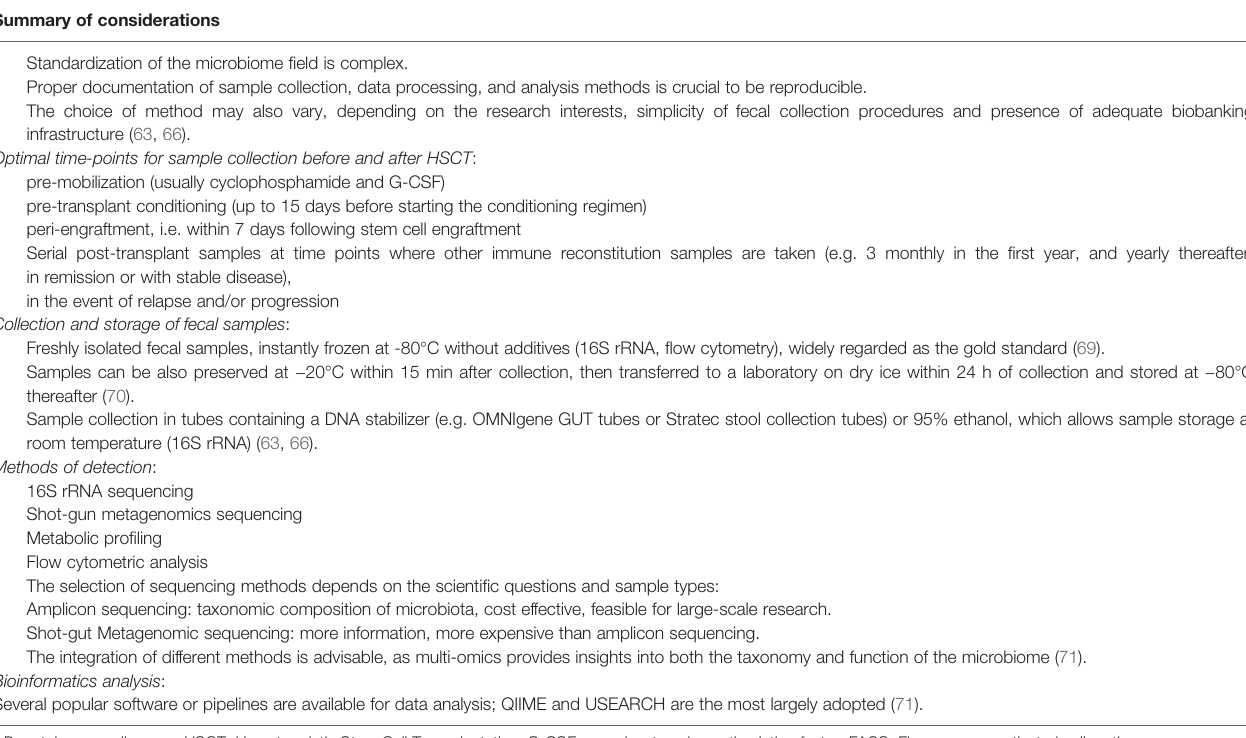
TABLE 2 | Considerations for the analysis of intestinal microbiome in AD undergoing